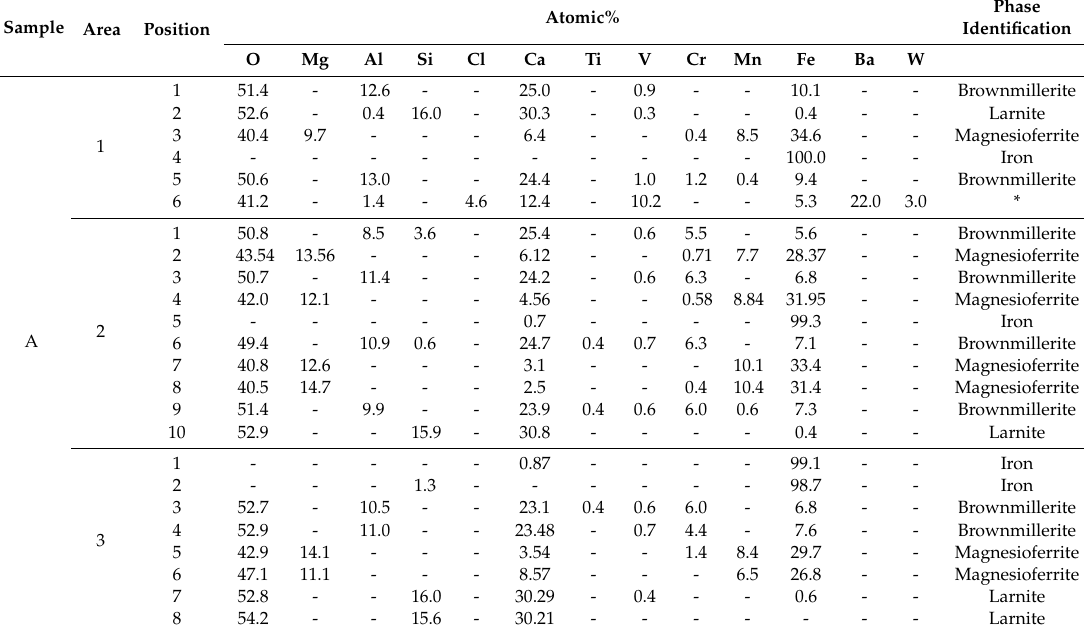
Table 3. EDXS analysis of sample A (molar%) in the points indicated in Figure 1 and the predicted crystalline